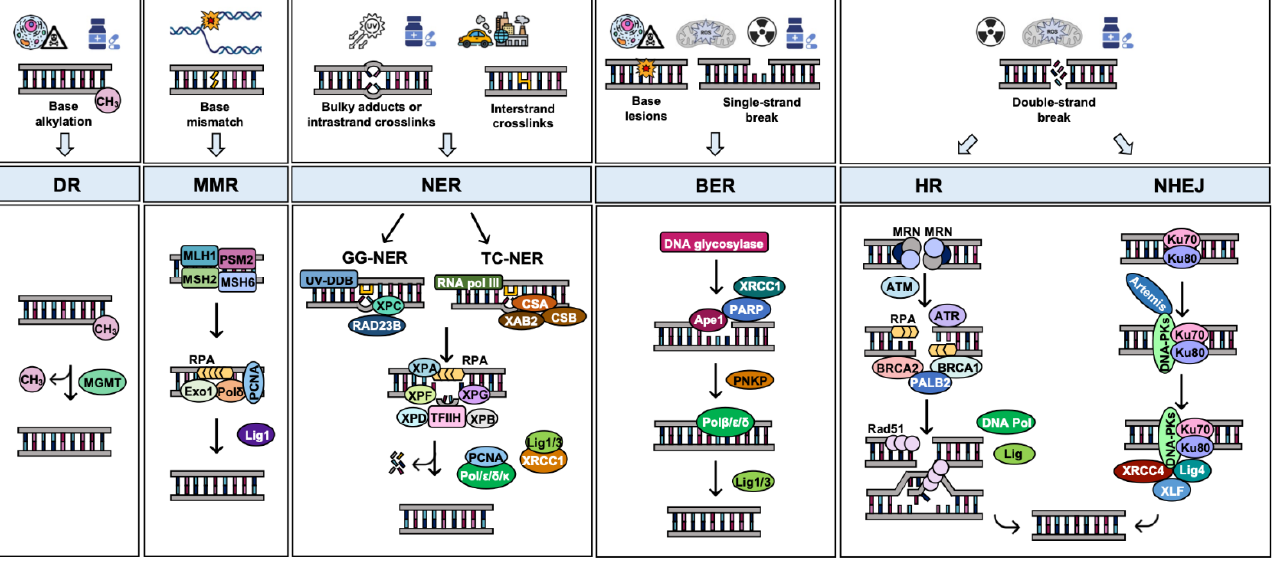
Figure 2. Schematic representation of the five major DNA repair pathways and the proteins involved. This figure has been created using images from BioRender.com and Flaticon.com.